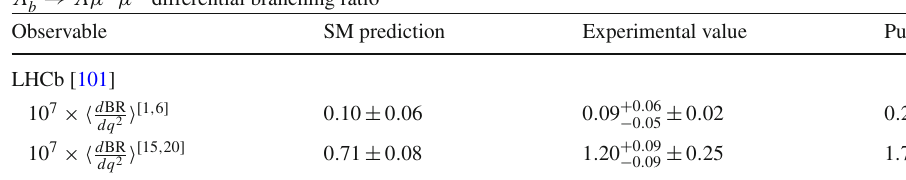
branching ratio of Λ 0 → Λμ + μ − included in the b global fit